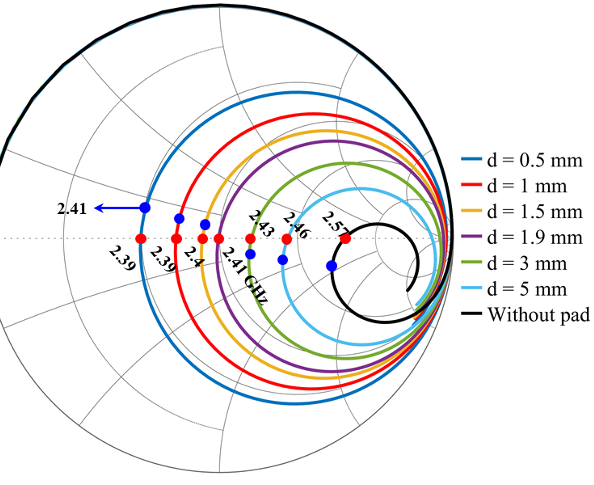
Figure 9. Reflection coefficient in the Smith chart among different d from DC to 4 GHz within which they cover the first resonance. When d = 1.9 mm, the loop impedance is matched at the desired resonant frequency of 2.41